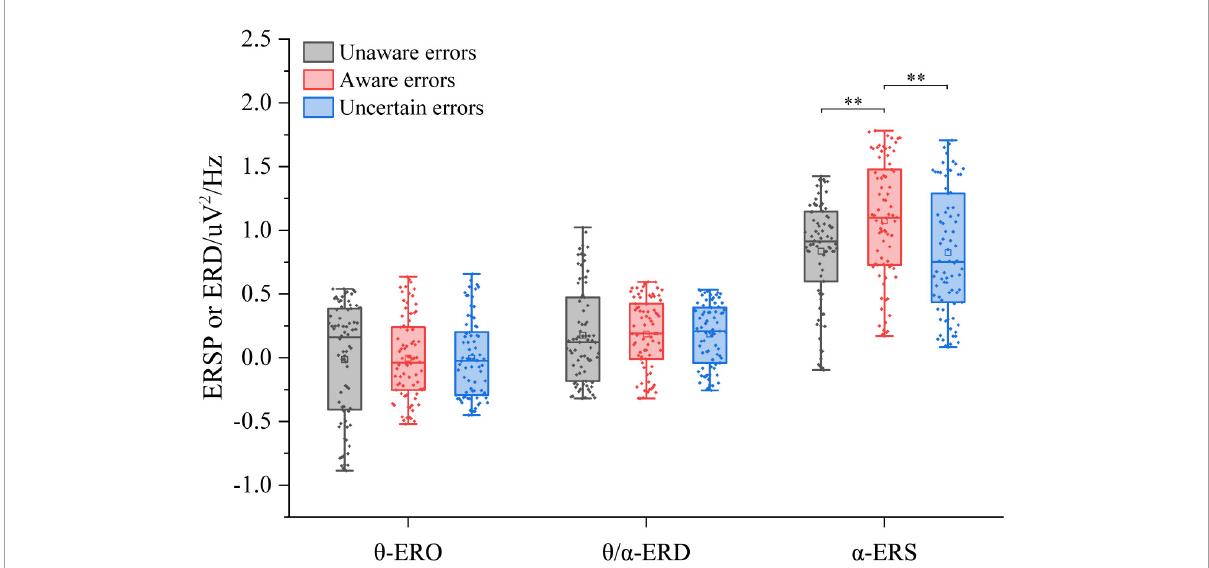
FIGURE4 ERSP/ERD of multiple error awareness on the region of interest ( n = 78). The squares in the box plots indicated the mean values, the horizontal lines indicated the medians, and both ends indicated the maximum and minimum values ( ∗∗ p < 0.001).